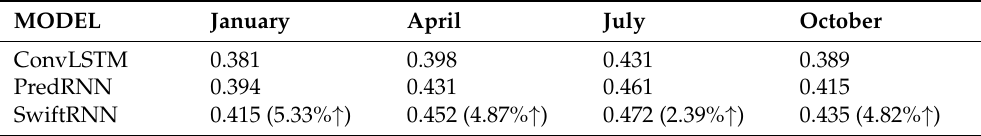
Table 3. The SSIM metric of visibility field map prediction for 4 months.